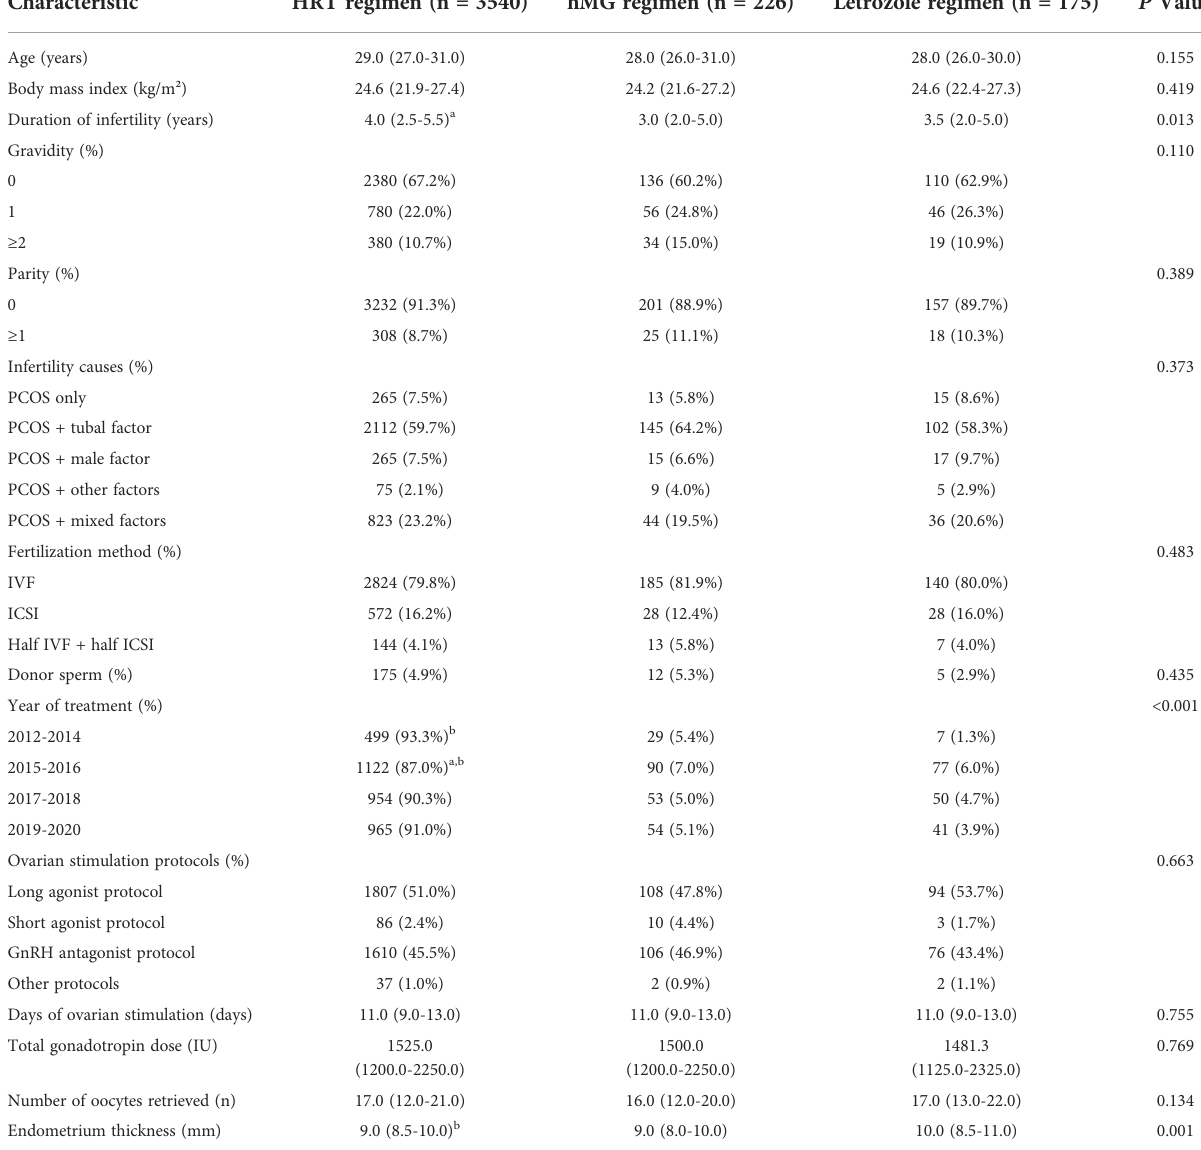
TABLE 1 Basic characteristics of the participants at cycle level by the different protocols.